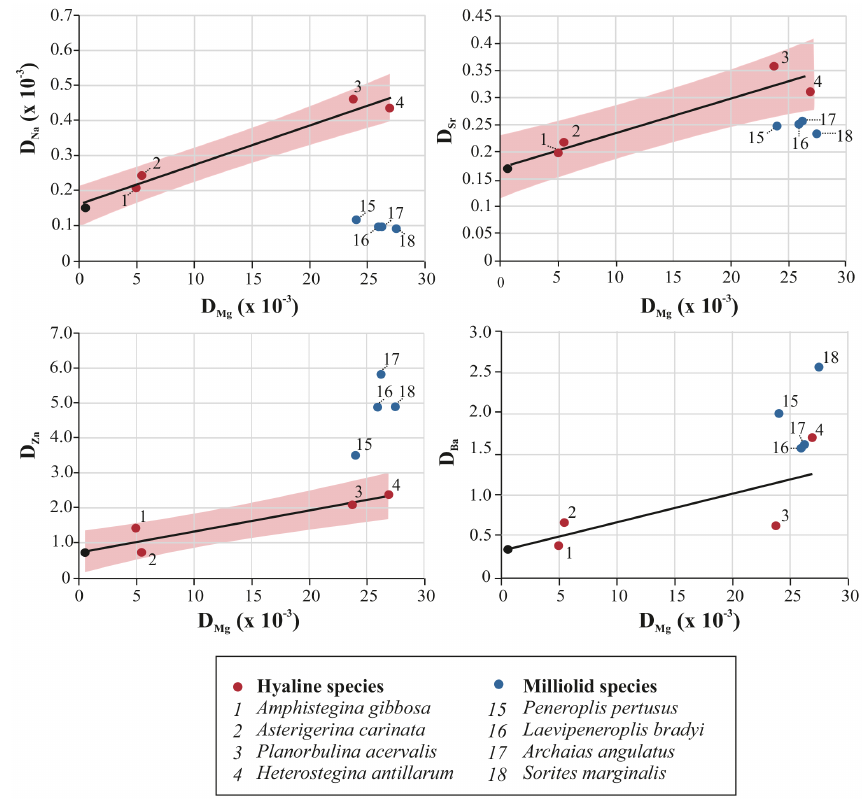
Figure 4. Partition coefficient of Na, Sr, Zn and Ba versus D Mg of hyaline (red symbols) and porcelaneous (blue symbols) species. Black lines represent linear trend lines. The 95% confidence intervals of signification trends ( p < 0.025) are indicated in red. Black dots represent the NFHS, in-house carbonate standard, consisting of planktonic foraminifera. Numbers correspond to foraminiferal species analyzed; numbers 5–14 and 19–21 represent values from previously published species and are included in Fig. S1 (in the Supplement).